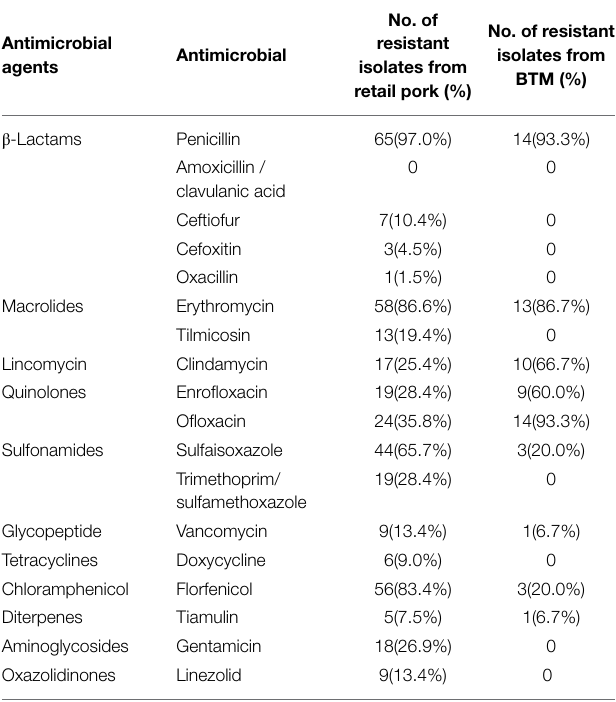
TABLE 1 | Number and percentage of antimicrobial resistance of S. aureus isolated from retail pork and BTM.